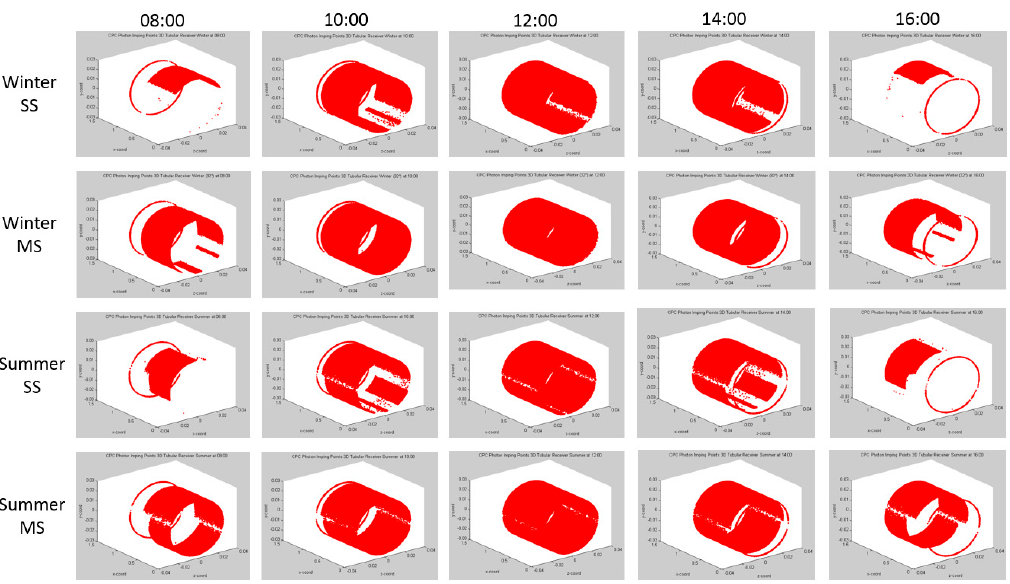
Figure 9. Photon impacts comparison for winter and summer in static setup (SS, 21°) and multi- position setup (MS, 0° for summer and 32° for